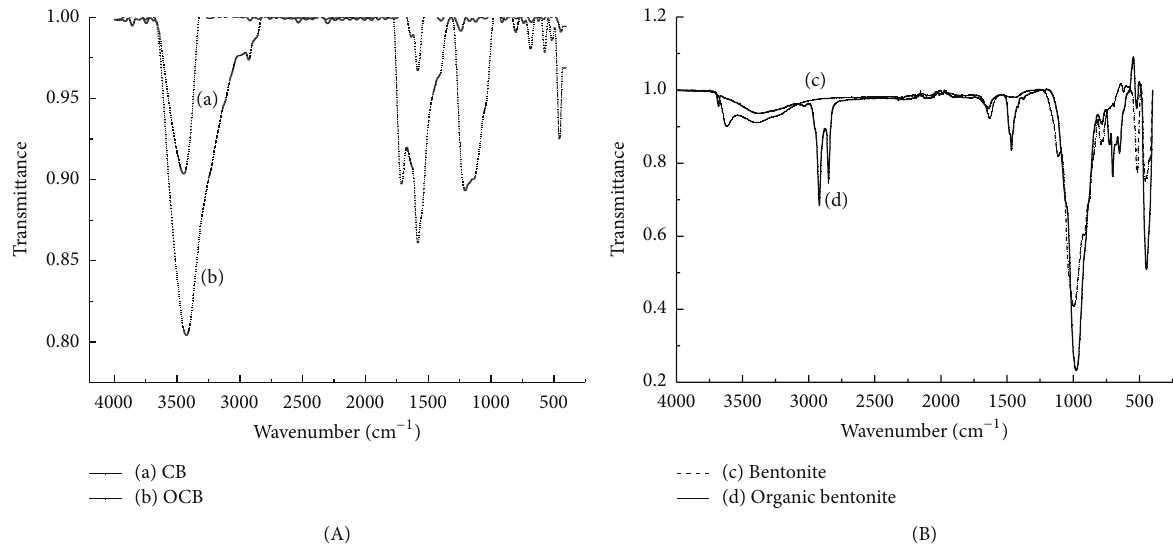
Figure 4: IR spectrum of different adsorbents. (a) CB, (b) OCB, (c) bentonite, and (d) organic bentonite.